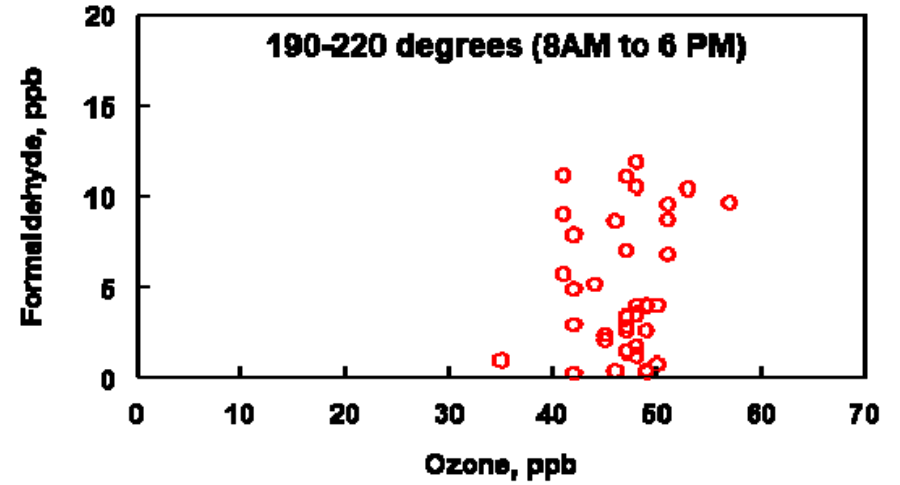
Figure 10. Comparison of ozone and formaldehyde concentrations between the indicated wind direction and time period for the months of April, May and June (2019).